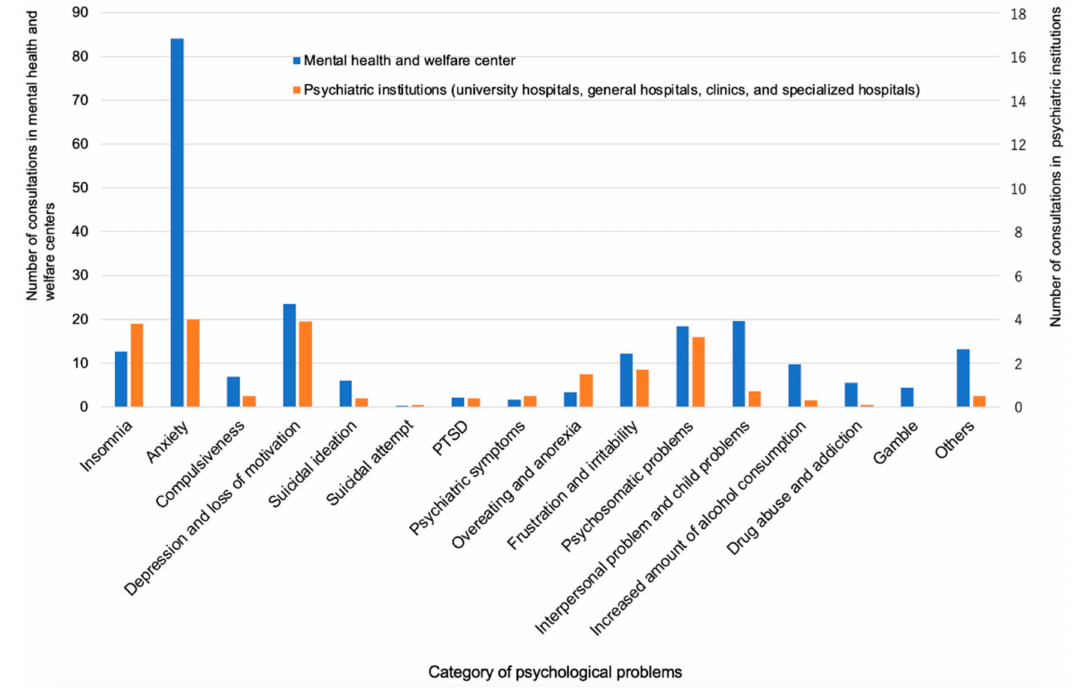
Figure 6. Categories of psychological problems.